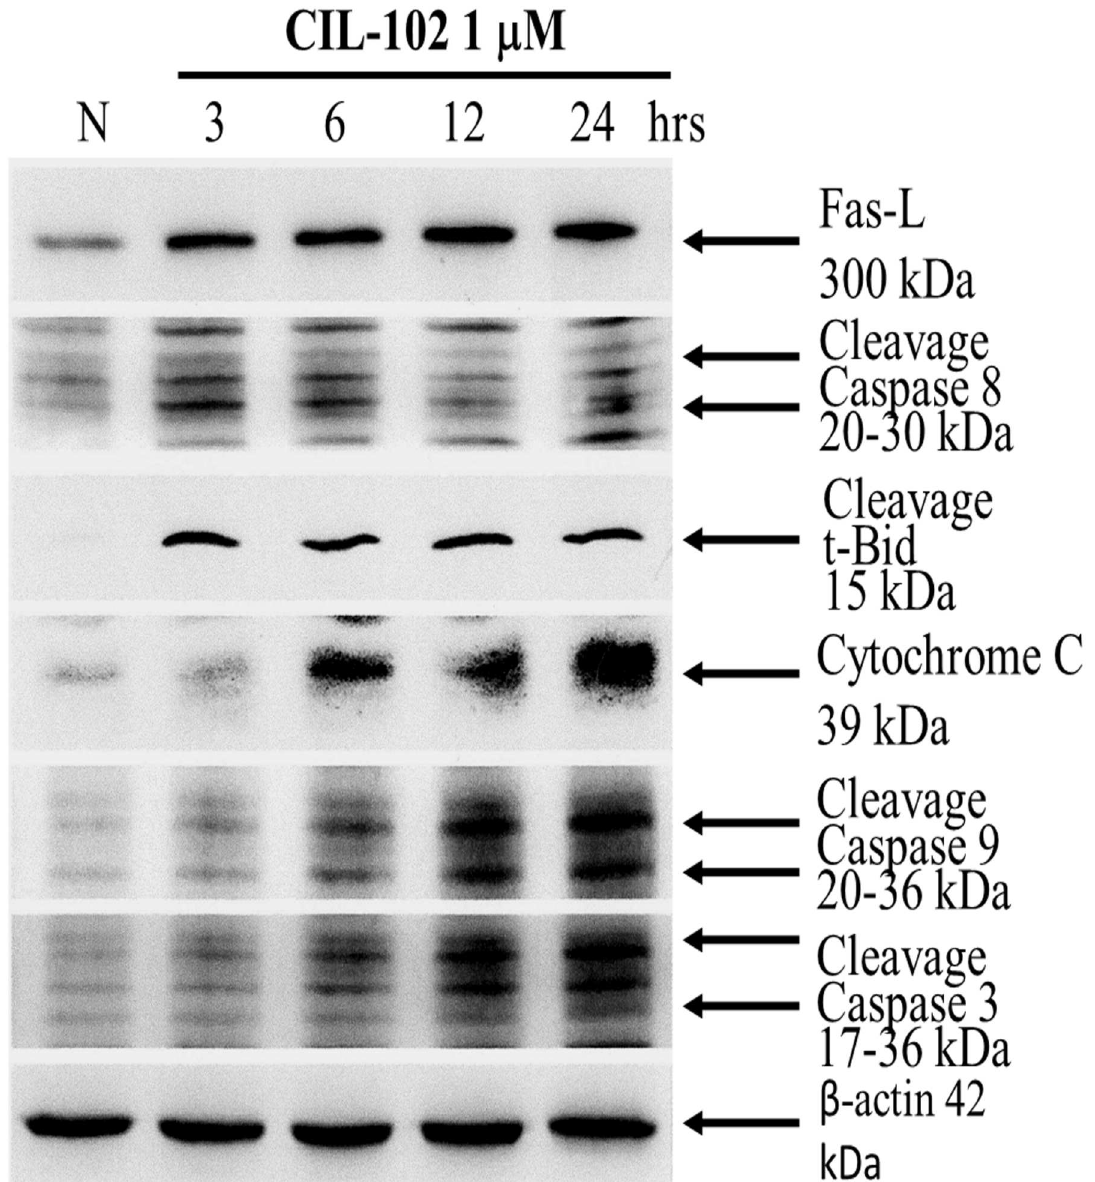
Fig 4. Effect of CIL-102 on Fas-L, caspase 8, t-Bid, cytochrome c, caspase 3 and caspase 9. Cells were treated with CIL- 102 for 0–24 hr, and were separatedby a 15% SDS–PAGE, and, subsequently, immunoblotted with antibodiesagainst Fas-L, cleavagecaspase 8, cleavaget-Bid, cytochrome c, cleavagecaspase 3 and cleavagecaspase 9, or b-actin which served as internalcontrol. CIL-102 inducedtranslocation of cytochrome c. Equal amounts of protein from cytosolic fraction of DLD-1 cells which has beentreated with 1 mM of